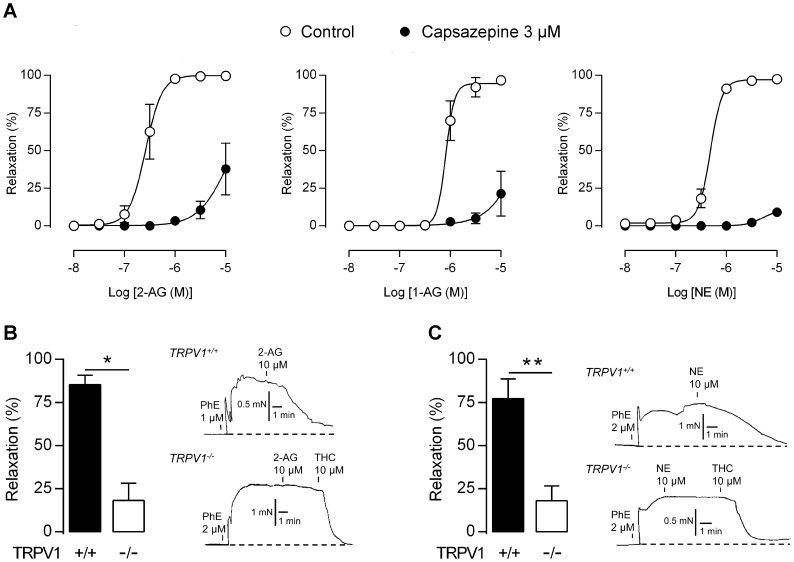
2-Arachidonoylglycerol, 1-arachidonoylglycerol and the stable 2-arachidonoylglycerol analog noladin ether activate native TRPV1.(A) Concentration-response curves for 2-arachidonoylglycerol (2-AG), 1-arachidonoylglycerol (1-AG) and noladin ether (NE) in the presence and absence of the TRPV1 antagonist capsazepine. Control experiments were performed in the presence of vehicle (0.1% ethanol). The MAGL inhibitor methylarachidonylfluorophosphonate (30 nM) was present in all experiments with 2-AG and 1-AG. The area under the curve was smaller in the presence than in the absence of capsazepine for all three lipids (P<0.01). Data are expressed as mean ± s.e.m. (n = 5–8).Vasodilator effect of 10 µM 2-AG (B) and NE (C) in isolated mesenteric arterial segments from TRPV1 knock-out (TRPV1−/−) and wild-type (TRPV1+/+) mice (n = 5). While 2-AG and NE produced only small responses in TRPV1−/− mice, subsequent application of the TRPA1 activator Δ9-tetrahydrocannabinol (THC) elicited an almost complete vasorelaxation, amounting to 90±2.5% and 94±2.0%, respectively (traces). The dashed lines show the basal tension level before addition of phenylephrine (PhE). Data are expressed as mean ± s.e.m.. *P<0.05, **P<0.01.